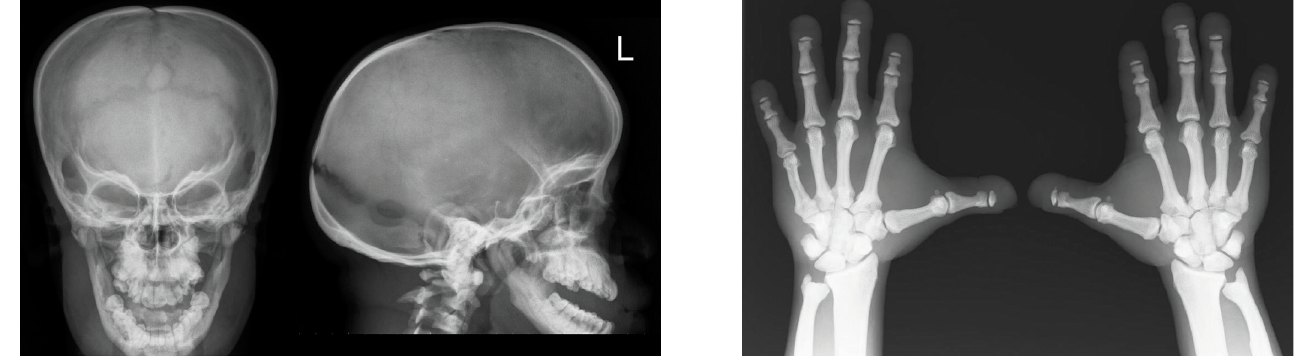
Fig. 1. AP and lateral skull X-rays reveal a large cranial vault with persistent open Fig. 2. AP X-ray of both hands demonstrate short stubby fingers with sutures and fontanelles as well as wormian bones. Hypoplastic facial bones with dysplastic nails and non-pneumatisation of the frontal sinuses and an underdeveloped mandible with an obtuse jaw angle are also demonstrated. Table 1. Characteristic clinical and radiographic features of pycnodysostosis